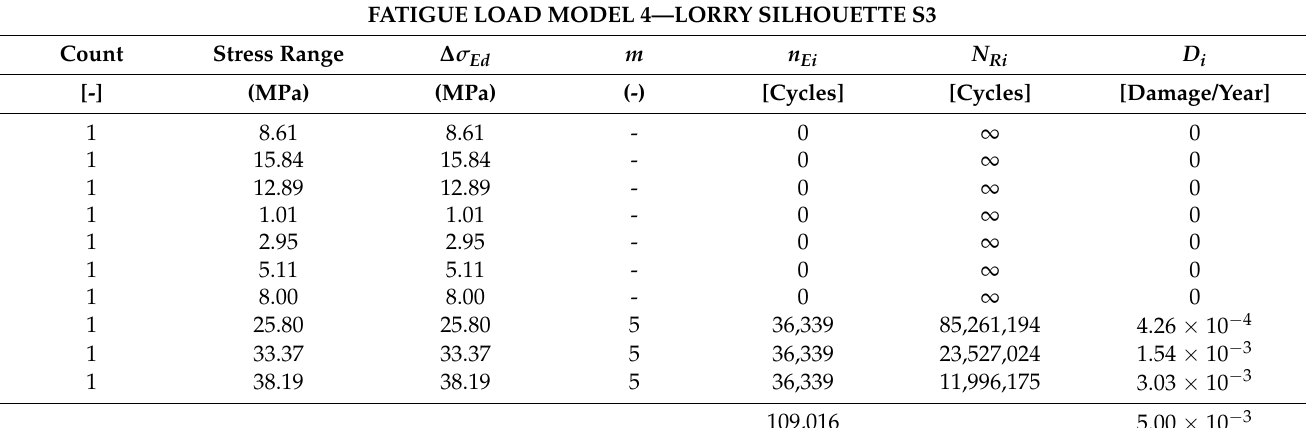
Table 6. Distinction of detail assessment: Rib-to-Plate—FLM4